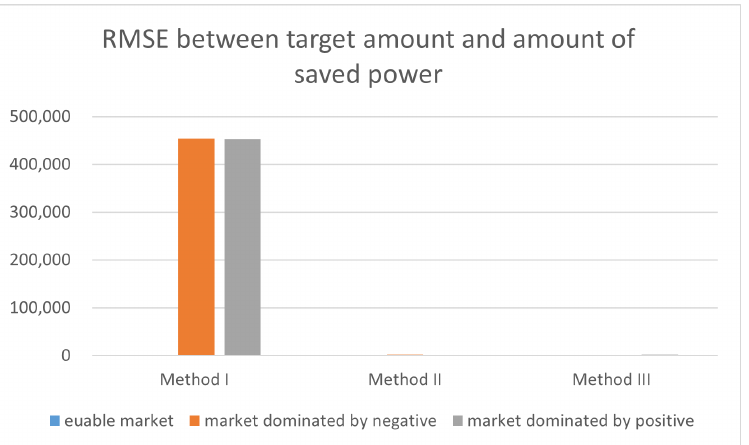
Figure 3. RMSE between the target amount of power saving and the amount of saved